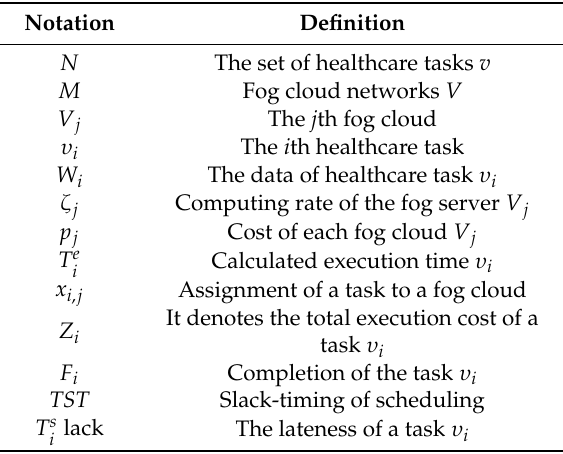
Table 1. Notations used for the